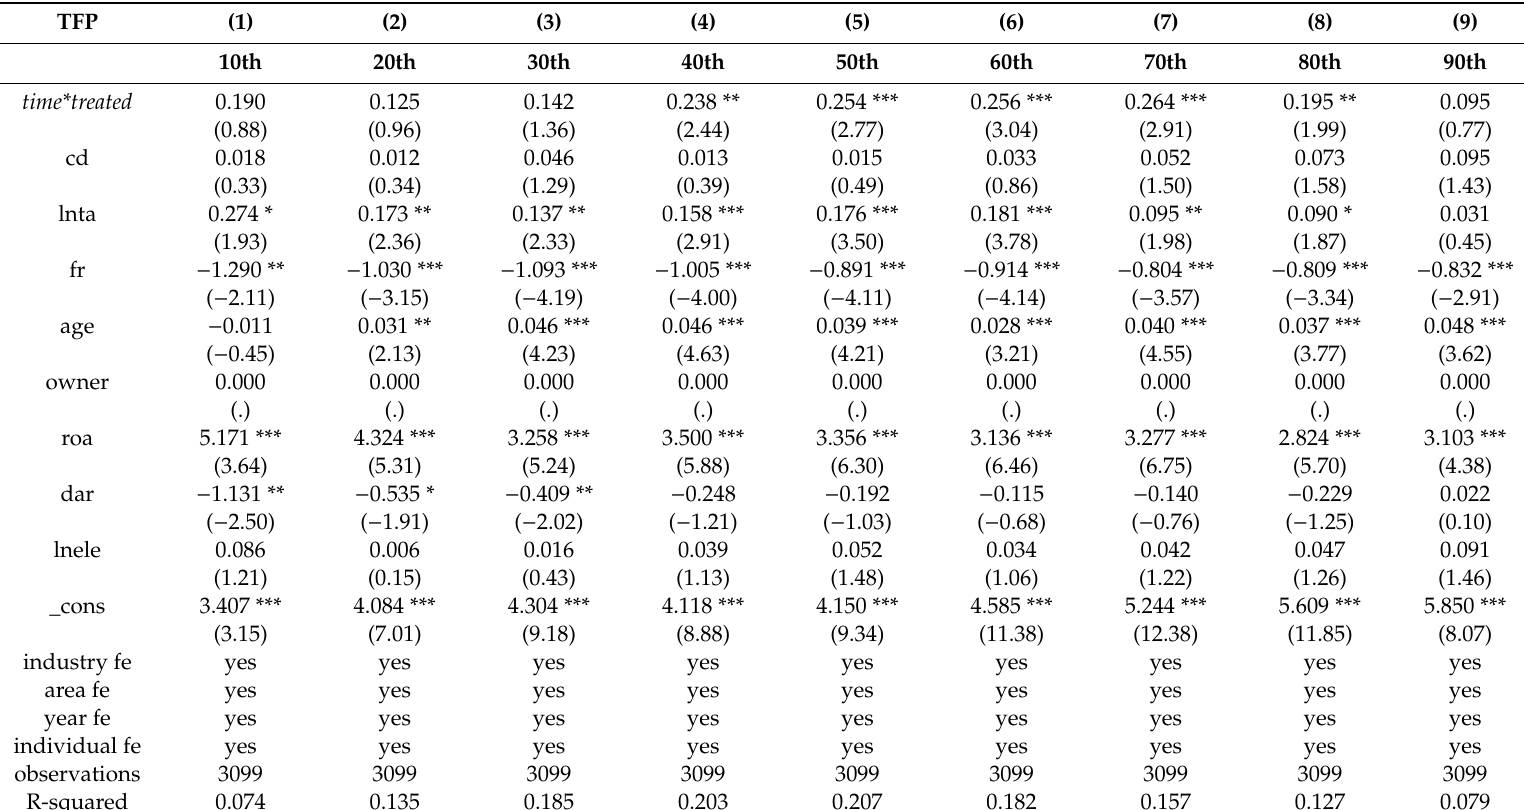
Table 6. Estimation results under di ff erent quantile level of enterprise